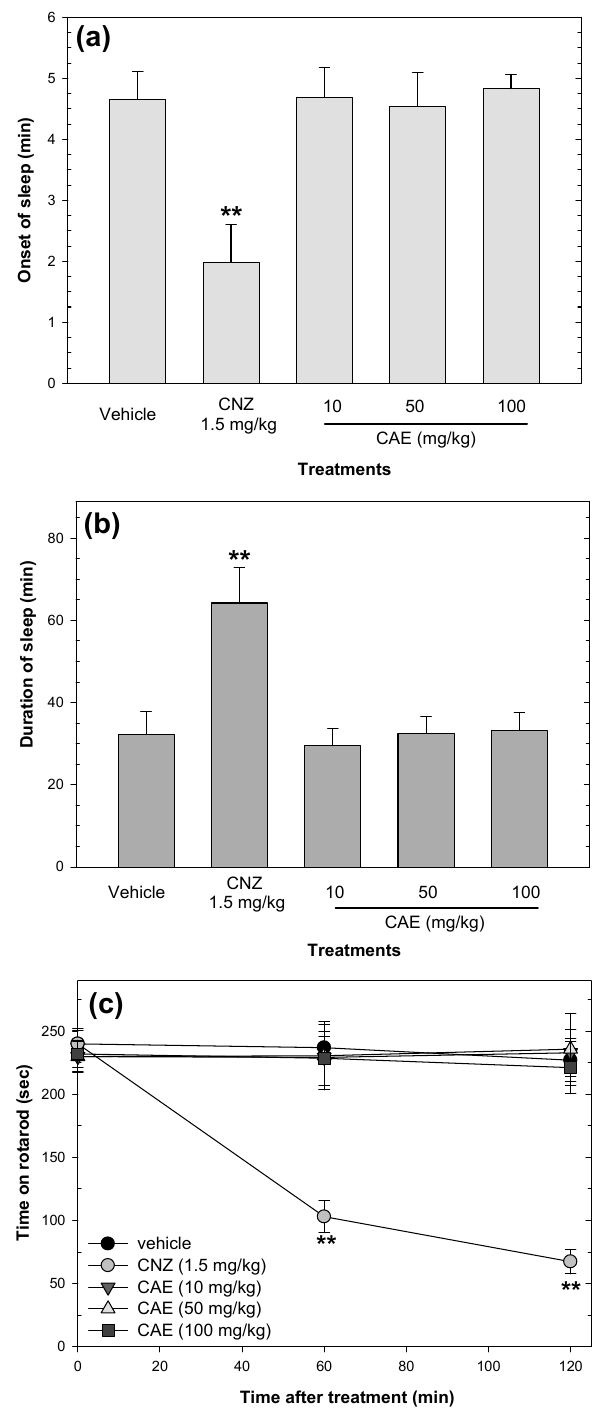
Figure 7 . Sedative and motor coordination effects of CAE (1–50 mg/kg p.o.). The sedative effects of CAE were measured by the onset of sleep ( a ) and the duration of sleep ( b ) in the pentobarbital- induced sleep test, and the effects of CAE on motor coordination were evaluated with the rotarod test ( c ). Clonazepam (CNZ) at 1.5 mg/kg p.o. was used as the positive control. Bars ( a , b ) and shapes ( c ) represent mean values (± SEM) for the experimental group. n = 8, ** p < 0.05 compared to the vehicle group.